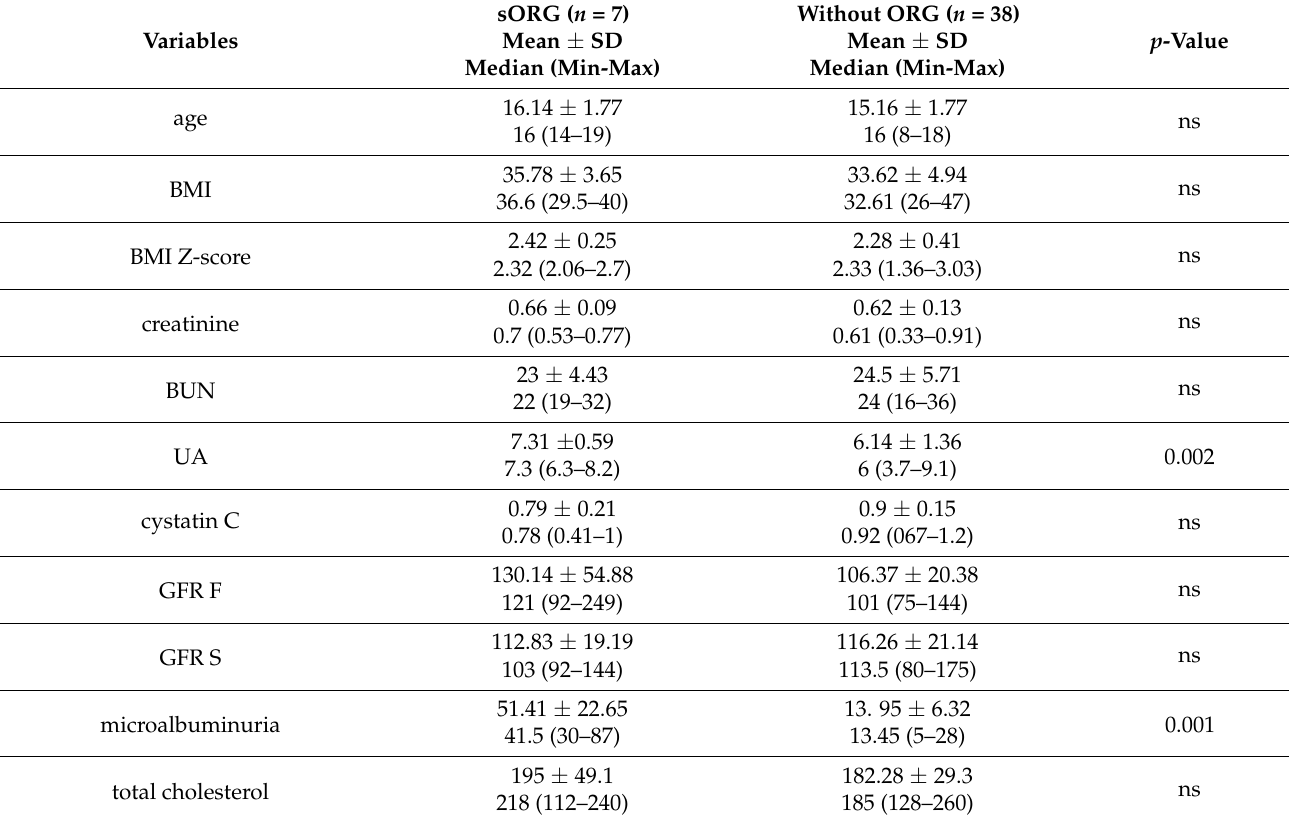
Table 4. Anthropometric, biochemical, and oral data under suspicion of ORG (sORG) and without ORG among